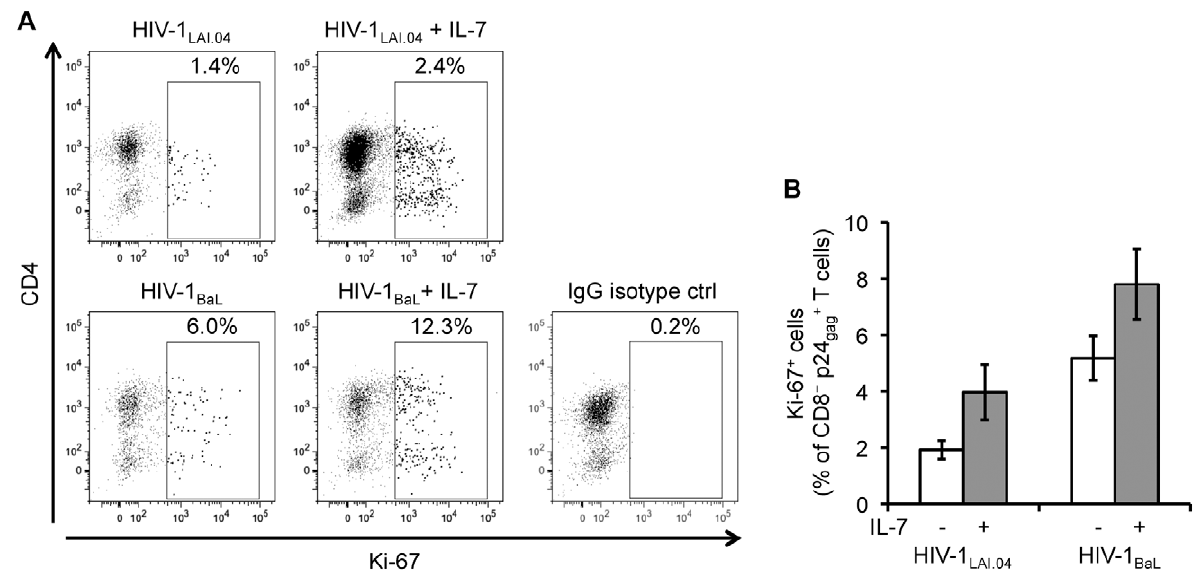
Figure 7. IL-7 increases the proliferation of HIV-1-infected CD4 + T cells. ( A ) Presented are dot plots for HIV-1-infected CD4 + (CD8 2 p24 gag + ) T cells isolated from lymphoid tissue blocks infected with HIV-1 LAI.04 or HIV-1 BaL treated or not treated with IL-7 25 ng/mL from a representative donor on day 9 post infection. The amount of Ki-67 + HIV-1-infected CD4 + T cells is expressed as percentage of total CD8 2 p24 gag + T cells. ( B ) Presented are the average fractions of HIV-1-infected CD4 + T cells expressing Ki-67 isolated from donor-matched lymphoid tissue blocks infected with HIV-1 LAI.04 or HIV-1 BaL treated or not treated with IL-7 25 ng/mL (means 6 s.e.m., n =6).